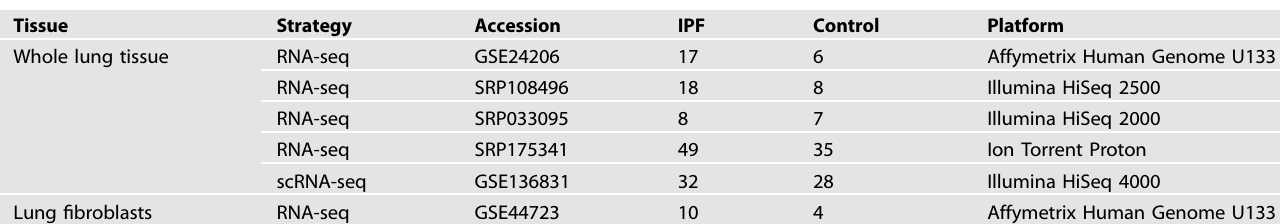
Table 1. Gene expression pro fi les used in our